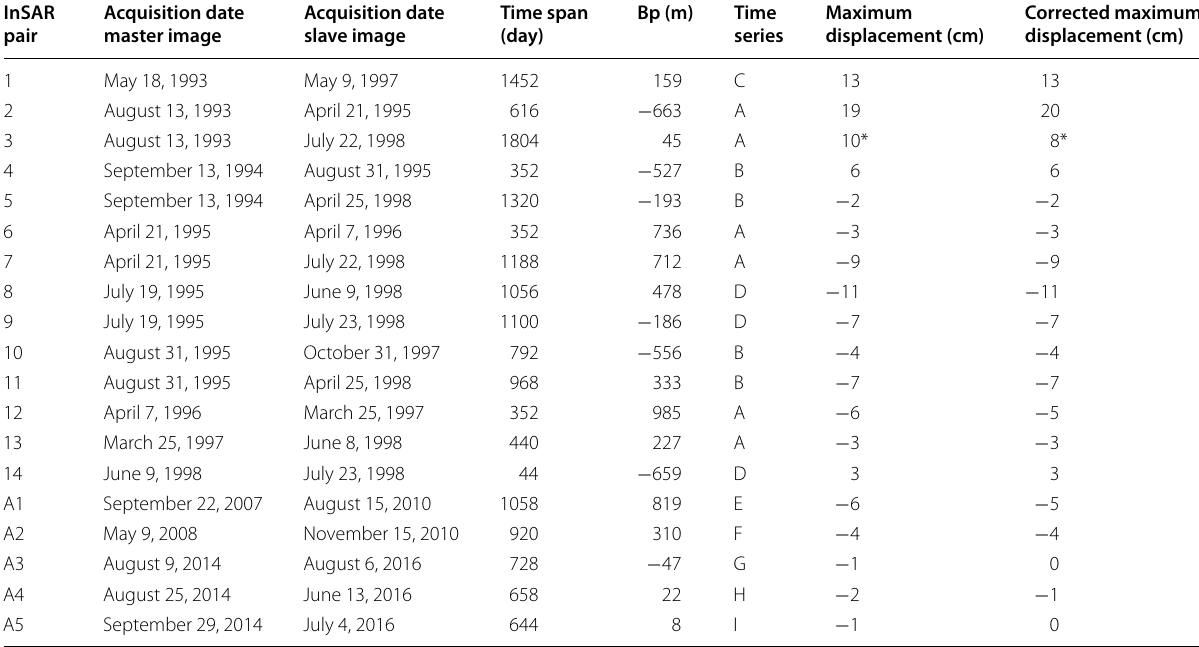
JERS-1 data are used in InSAR pairs 1–14, ALOS data are used in A1 and A2, and ALOS-2 data are used in A3, A4, and A5. InSAR data were acquired from descending orbit except for InSAR pair A4. The off-nadir angle of JERS-1 is 35°, and that of A1, A2, A3, A4, and A5 is 34.3°, 34.3°, 29.1°, 32.4°, and 38.2°, respectively. Bp means a perpendicular baseline. There are nine time series; A–I. Temporal evolution of displacement can be obtained only from InSAR pairs belonging to the same time series. Maximum displacement shows the maximum displacement in LOS direction in each SAR interferogram. Corrected maximum displacement is obtained by subtracting constant small-scale displacement from the maximum displacement. *Because InSAR pair 3 was highly decorrelated and noisy, the maximum displacement value was not